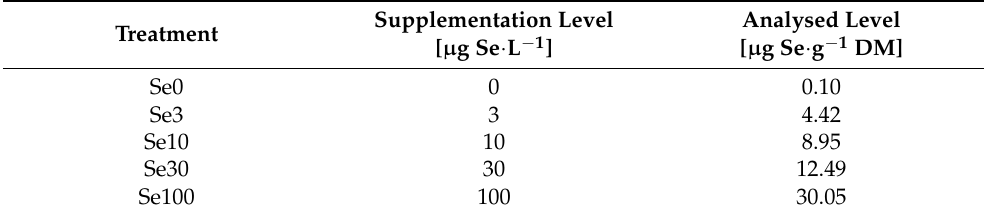
Table 1. Supplementation levels and analysed selenium concentrations in rotifer Brachionus rotundi- formis enriched in culture medium for 18 h with different doses of seleno-yeast (SelPlex ® ) and used as starter feeds for ABT larvae in the feeding